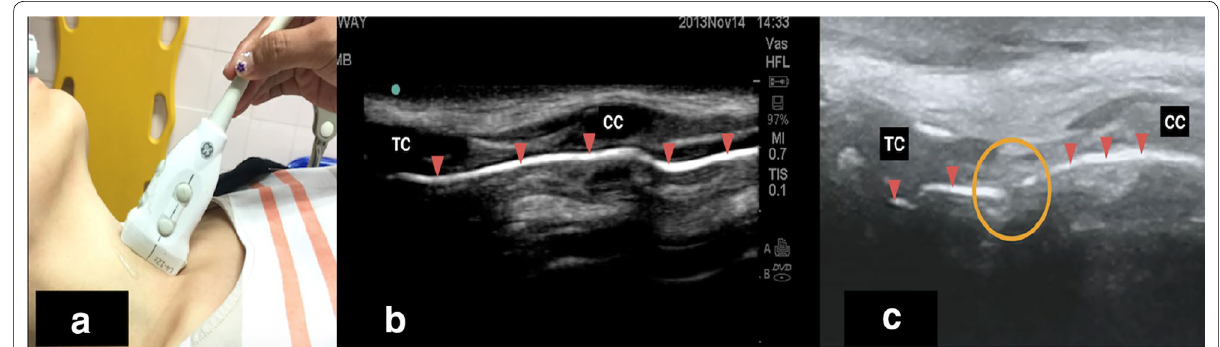
Fig. 1 a Surface landmark of probe position (in longitudinal view) in relation to scanning the area for b and c . b Normal sonoanatomy of upper airway showing the relationship between thyroid cartilage, cricoid cartilage, air–mucosal interface and surrounding soft tissues. A continuous and undisrupted line of air–mucosal interface seen as hyperechoic line (arrowhead) c Airway ultrasound showed disruption air–mucosal interface without obvious detectable laryngeal fracture (circle). SM: sternocleidomastoid muscle; TC: thyroid cartilage; CC: cricoid